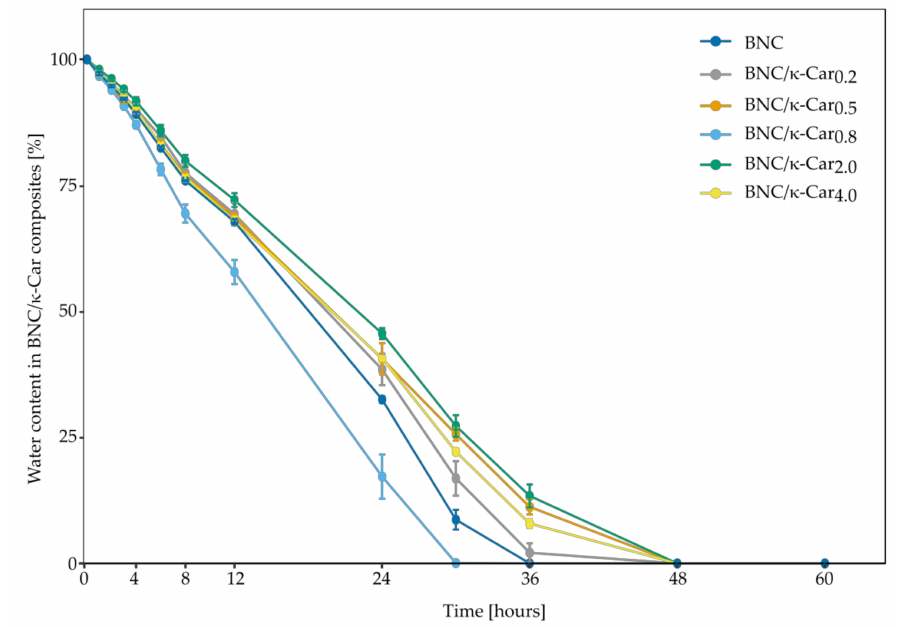
Figure 7. Water retention ratio of BNC and BNC/ κ -Car composites. (The data are presented as the means ± SD from at least three independent experiments).